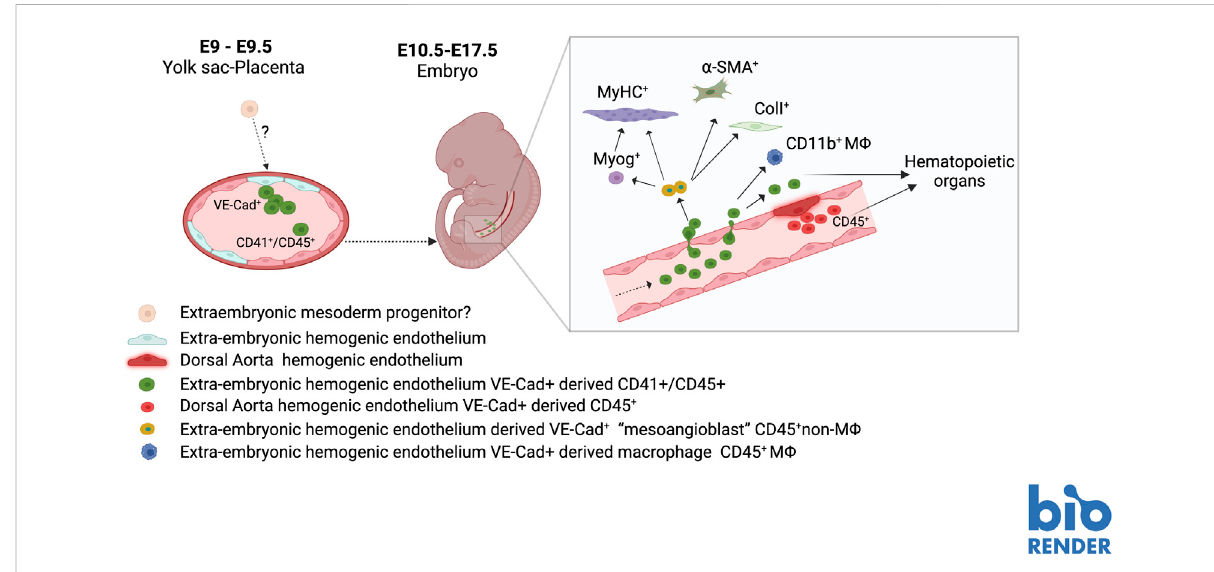
FIGURE 2 Hypothetical scheme of the origin of MABs in during mouse embryo